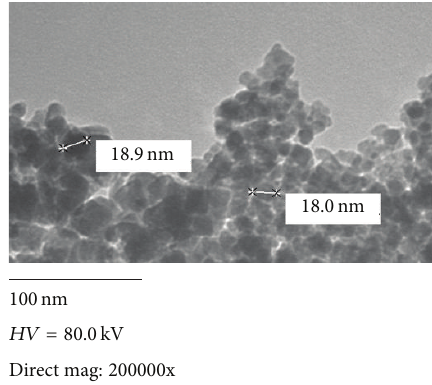
Figure 5: TEM photograph for the as-synthesized Ag-TiO 2 /Fe 3 O 4 .